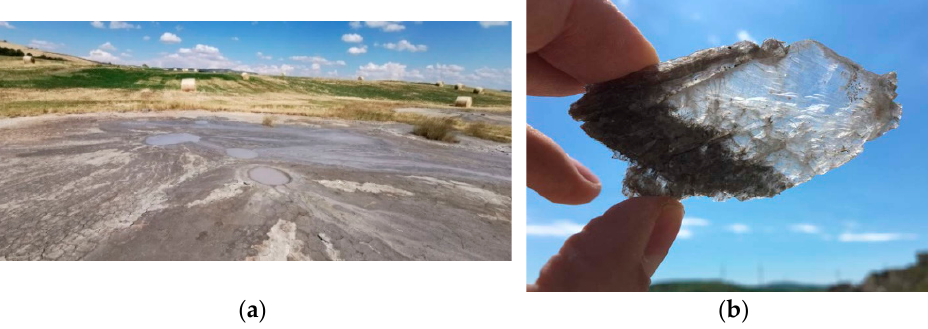
Figure 8. Methane emissions and gypsum deposits: ( a ) mud volcanoes at the Bolle della Malvizza in Montecalvo Irpino (AV); ( b ) the gypsum of Savignano Irpino quarries (AV).